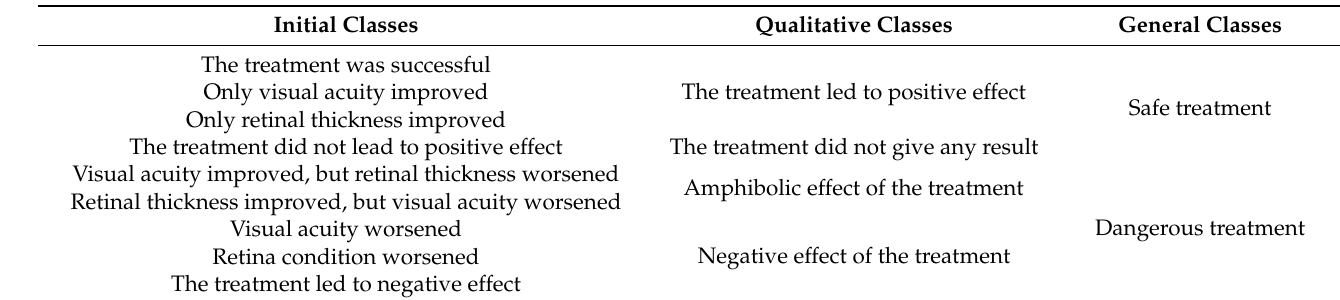
Table 2. Description of